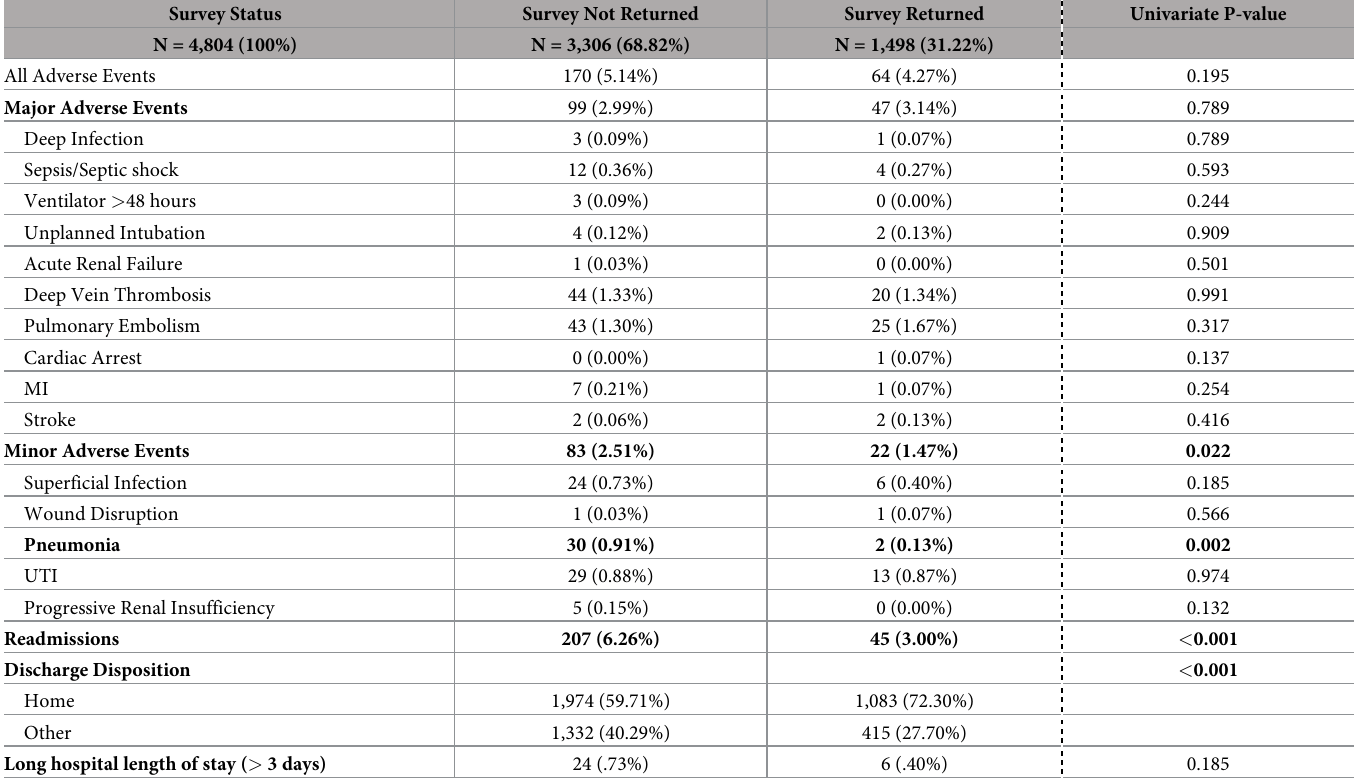
Table 2. Adverse event outcomes following primary TKA organized by status of HCAHPS survey